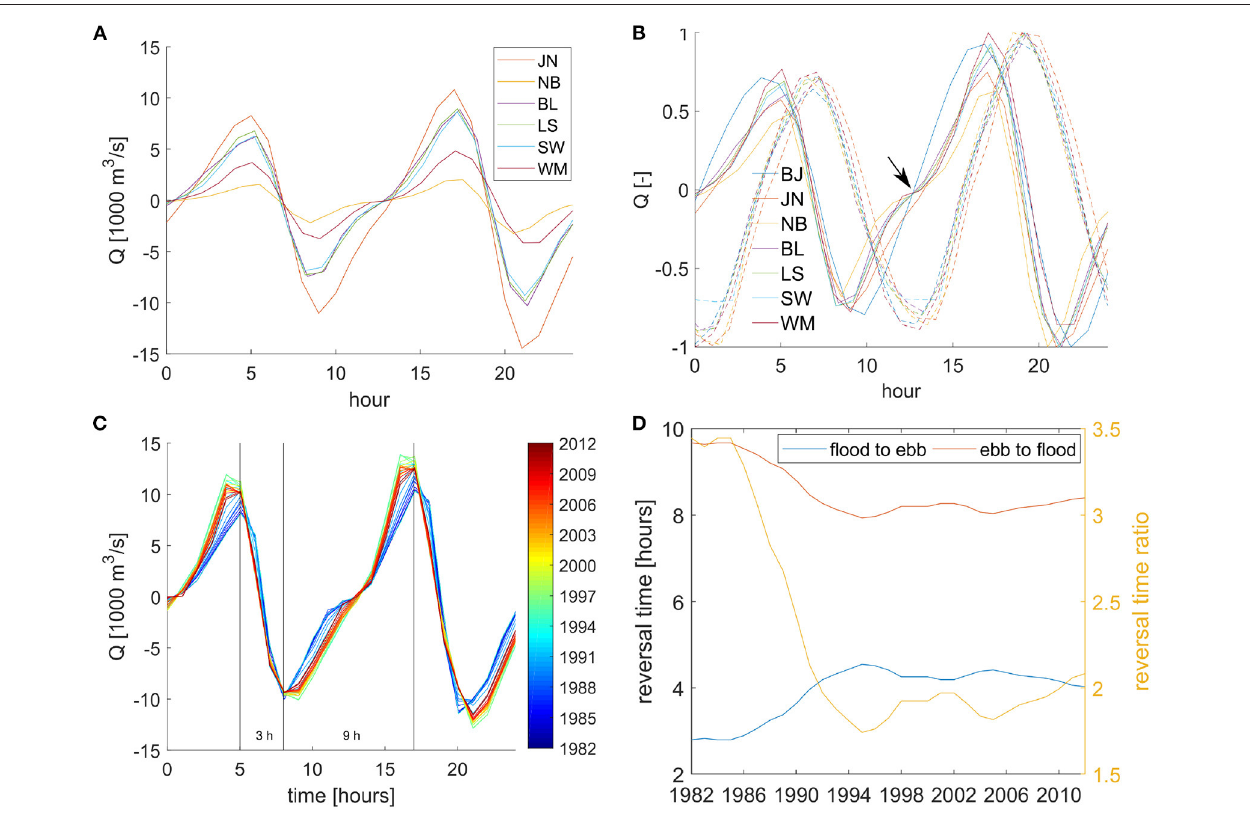
FIGURE 7 | Transport (positive is flood-directed) through the inlets of the EFWS (A) and their corresponding normalized curves (B) for two M2 tidal cycles in 1982. The dashed lines in (B) shows the normalized sea level curves. The arrow marks the inflection point during transition from peak ebb to peak flood velocity. (C) Transport in the inlet between the islands of Langeoog and Spiekeroog for the different years (colors). (D) Estimates of the durations of peak flood to peak ebb vs. peak ebb to peak flood asymmetry. The curve for the intertidal basin behind the islands of Borkum and Juist is not shown in (A) because of the much larger amplitude. To better compare the individual curves in (A,B) , the phases have been